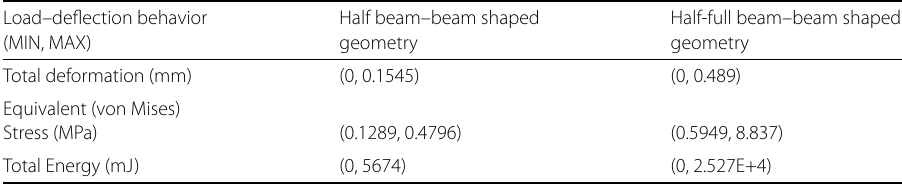
Table 3 Structural analysis. Load-deflection behavior of bridge structure with different shaped geometries of the main beam